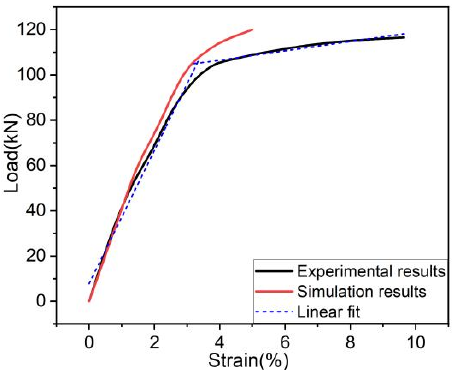
Figure 15. Load-strain curves obtained from the experiment and FEM.